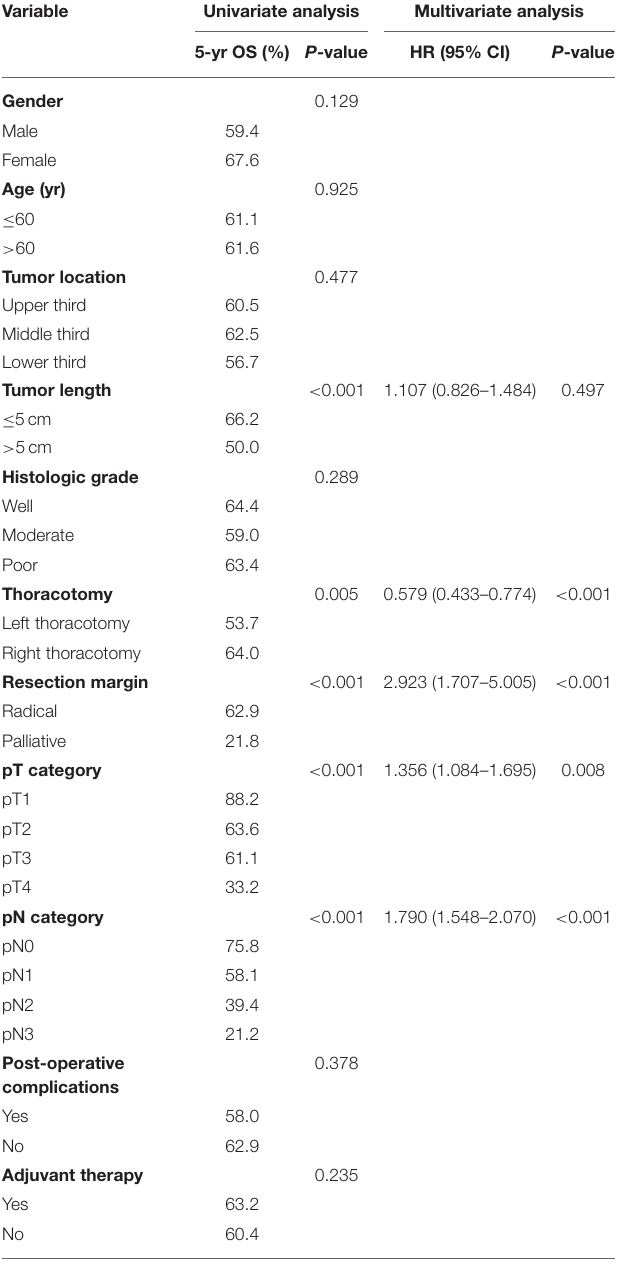
TABLE 4 | Univariate analysis and multivariate analysis in regard to overall survival according to nutritional parameters. Variable Univariate analysis Multivariate